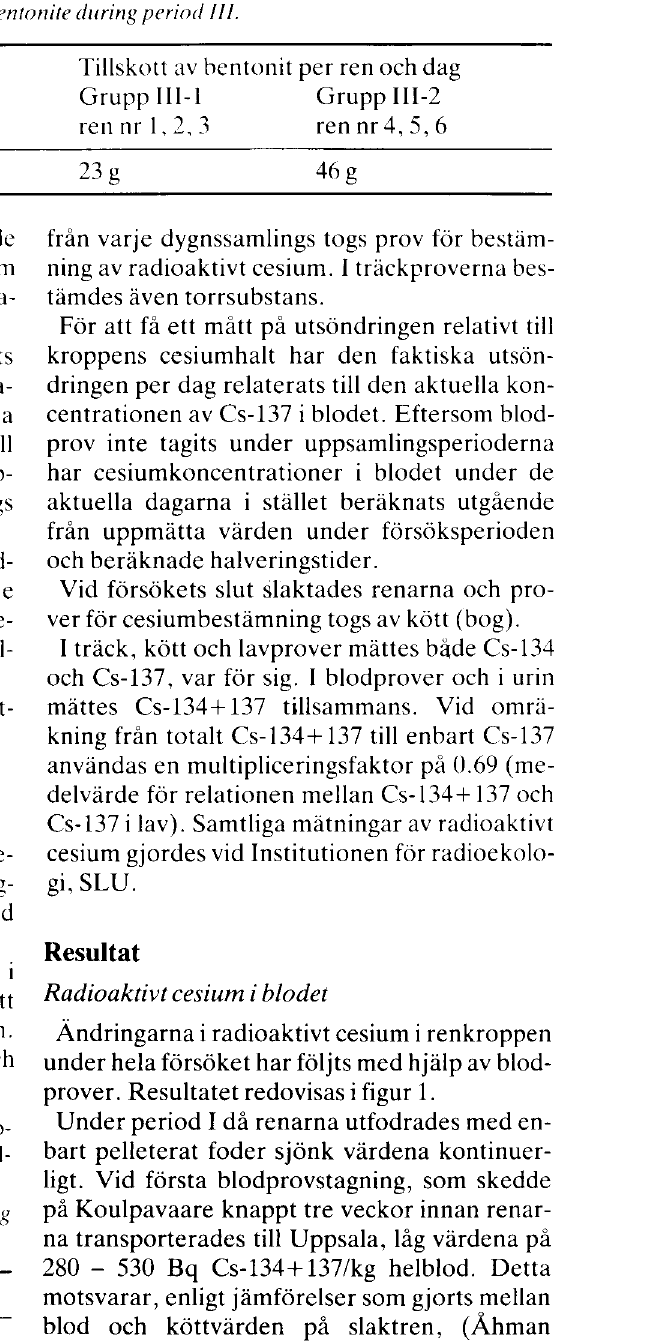
Table 4. Chemical composition of pellets used during the